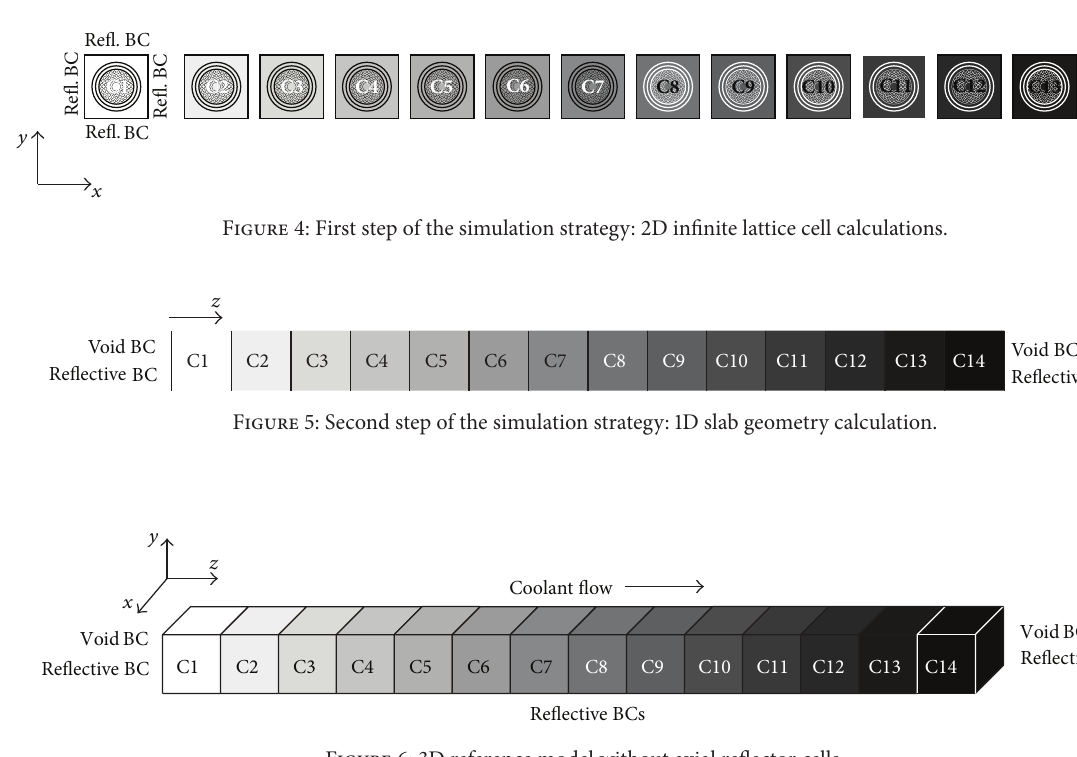
Figure 6: 3D reference model without axial reflector